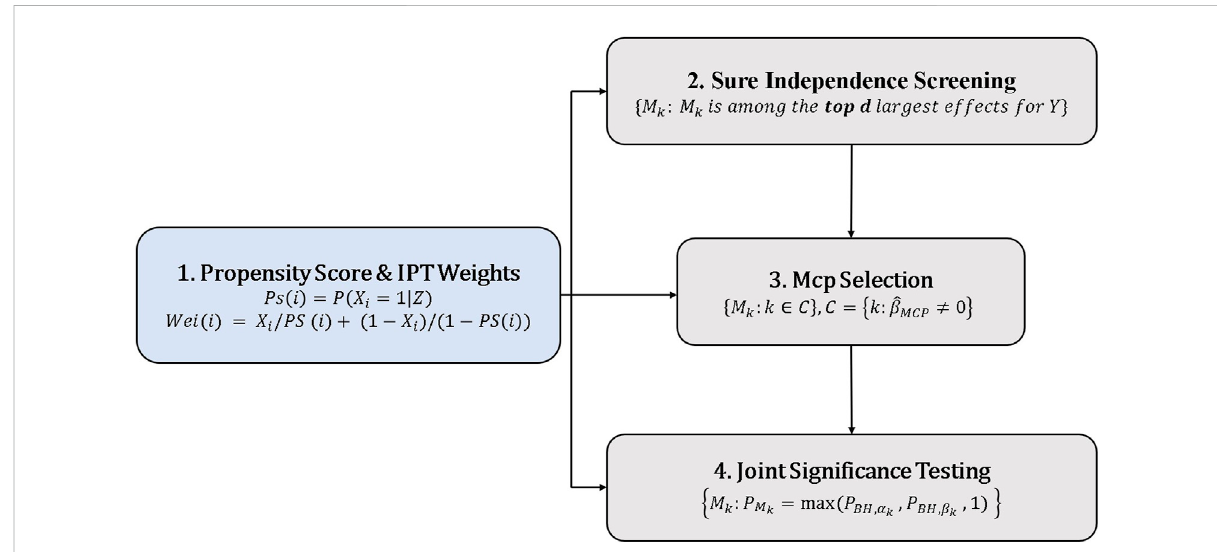
FIGURE 2 The structure of the high-dimensional mediation models with PS adjusting for